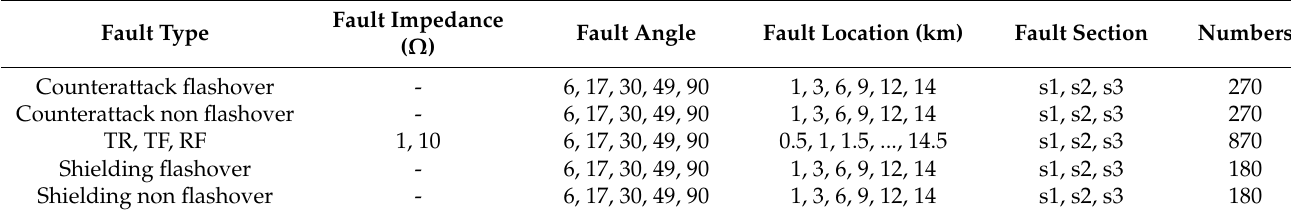
Table 2. Fault type training and test conditions.